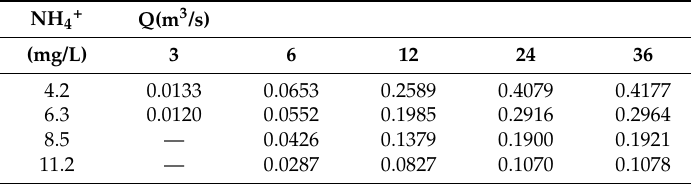
Table 8. The typical values of exceedance probability of COD Mn.